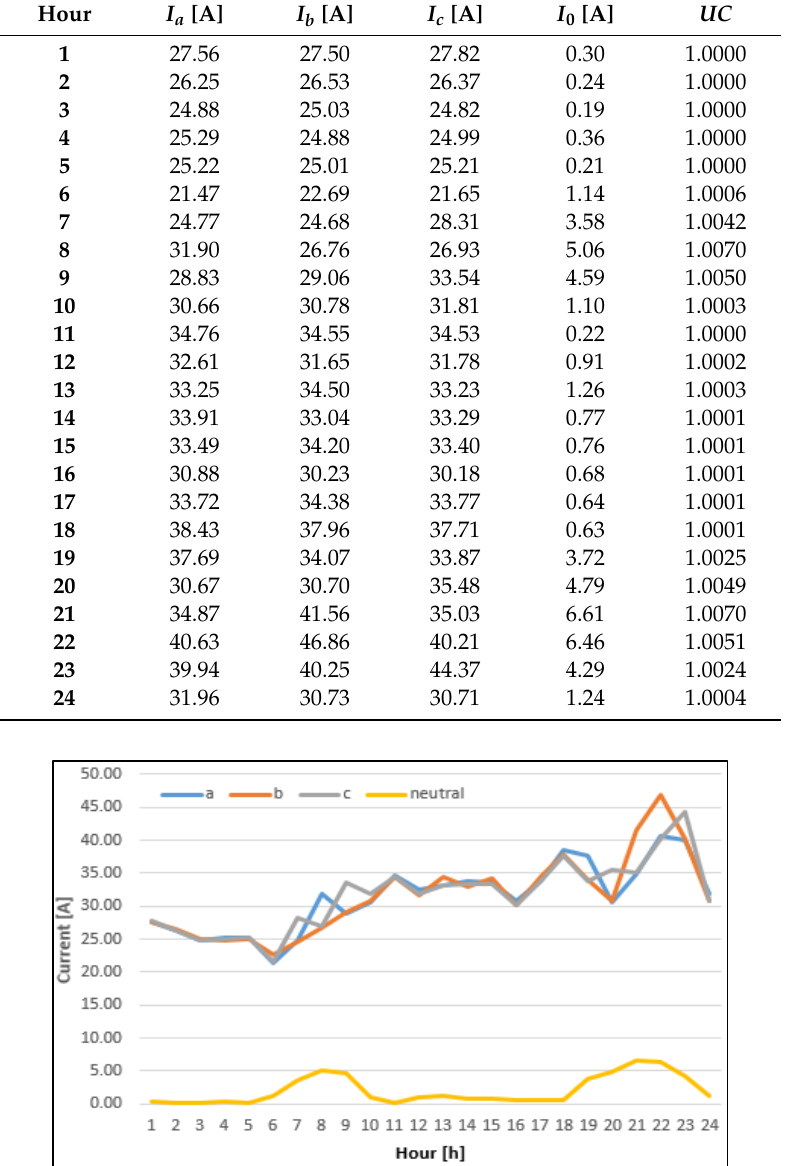
Table 8. The currents in the conductors of the first branch, SP-Pillar 8, the proposed algorithm.